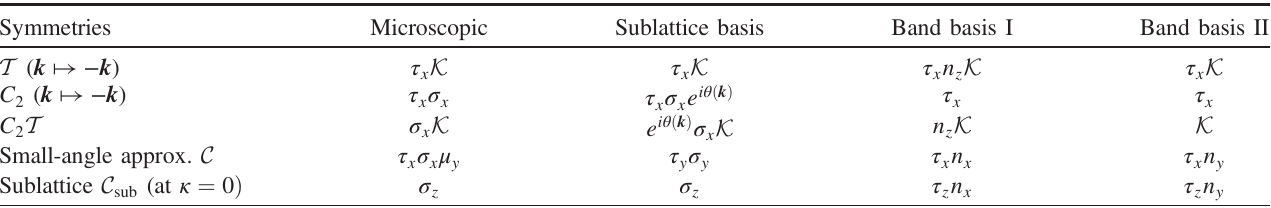
TABLE III. Representations of symmetry operators in different bases. The sublattice basis is constructed in Ref. [27], and the band basis I is explicitly constructed in the discussion. The band basis II can be obtained for a different gauge choice. Among these operators, T and C flip the momentum k . Note that the above choice is not unique. The following relations should be satisfied: ½ T ; C 2 T (cid:3) ¼ ½ T ; C sub (cid:3) ¼ f T ; C g ¼ 0 , f C 2 T ; C sub g ¼ f C 2 T ; C g ¼ 0 , f C ; C sub g ¼ 0 . Furthermore, in the band basis, chiral symmetries C and C should anticommute with n . Depending on the detailed setting of the simulation, we may use one basis over the other. Note z sub that C does not have a proper representation on the flat-band subspace if we are away from the chiral limit. Therefore, its sub representation would only be valid at the κ ¼ 0 limit.